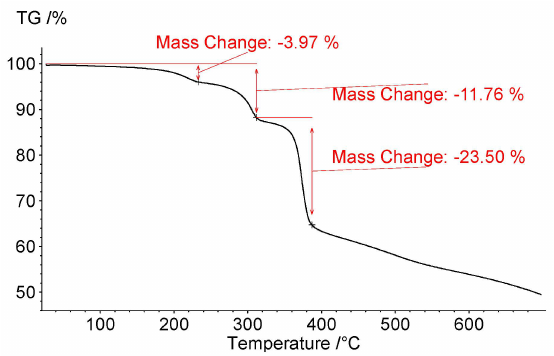
Figure 2. Thermogravimetric analysis (TGA) of 1 in the temperature range 20–700 ˝ C.